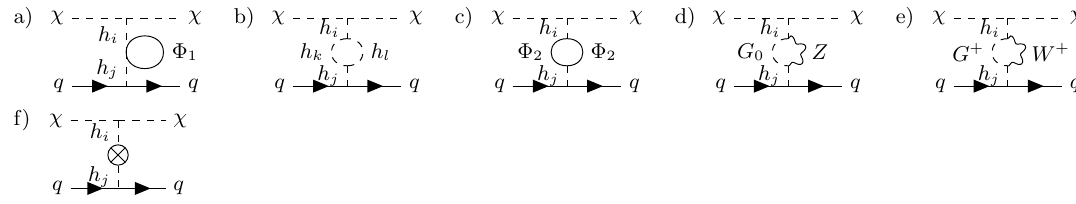
Figure 3 . The one-loop EW corrections to the mediator. They can be split in the genuine one-loop diagrams a)-e)) and the respective counterterm amplitude (diagram f)). The indices i, j, k, l = 1 , 2 indicates the respective Higgs mediator h 1 , h 2 . The possible field insertions are given by Φ 1 = { h i , χ, G (0 , ± ) , Z, W ± } and Φ 2 = { χ, G (0 , ± ) , Z, W ± , η Z , η W , f } , where f stands for all SM fermions, G (0 , ± ) for the neutral and charged Goldstone bosons, respectively, and η Z,W for the ghost